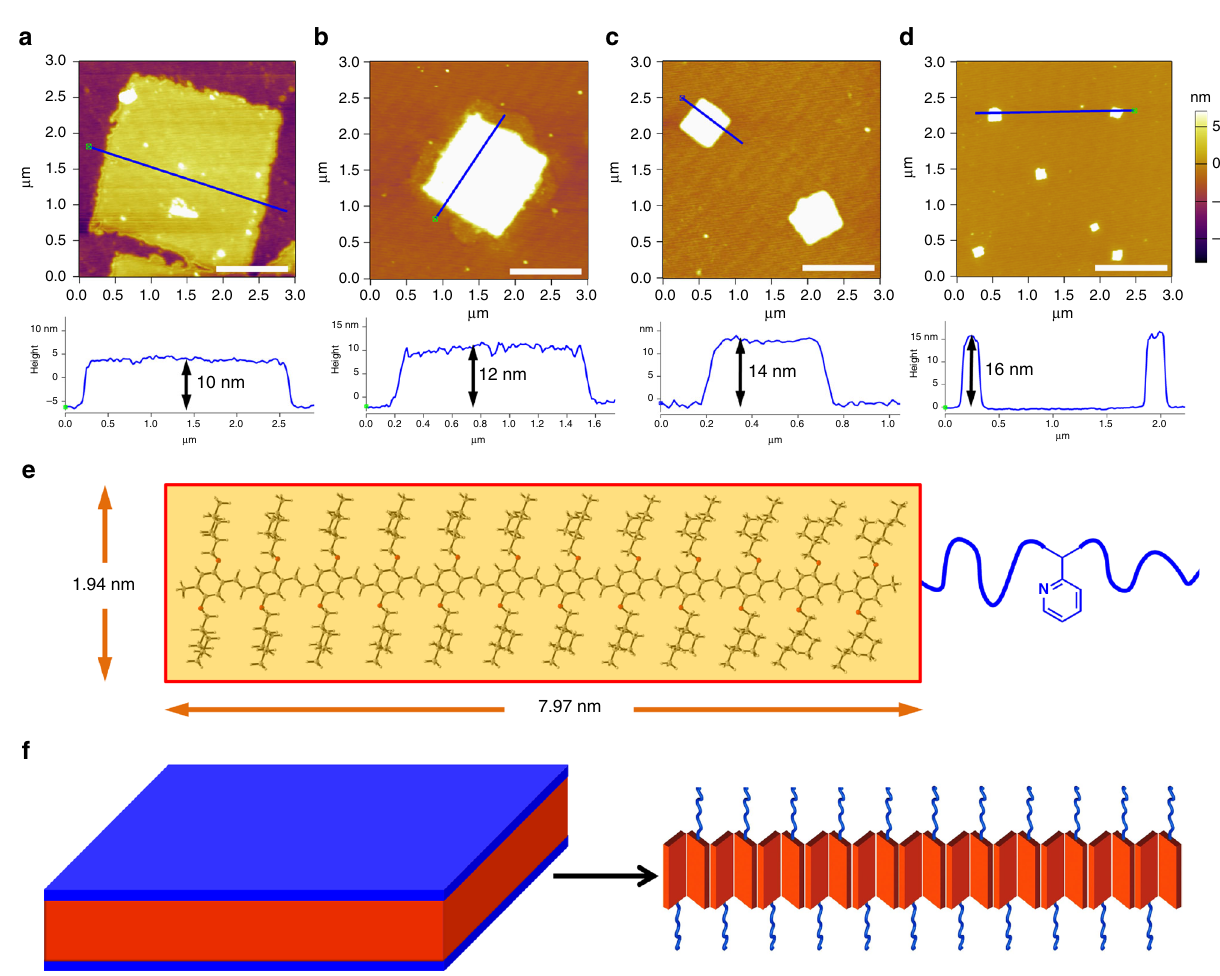
Fig. 2 Probable conformation of platelet 2-D square micelles. AFM images of 2-D square micelles obtained from a 0.01mg ml − 1 2-PrOH solution of PPV 12 - b - P2VP 12 , b 0.01mg ml − 1 2-PrOH solution of PPV 12 - b -P2VP 16 , c 0.05 mgml − 1 2-PrOH solution of PPV 12 - b -P2VP 22 , d 0.05mgml − 1 2-PrOH solution of PPV 12 - b -P2VP μ m in AFM images. e The optimized structure and calculated scales of conjugated PPV 36 in the height mode. Scale bars correspond to 1 12 block by DFT calculations. The DFT calculation was performed with the Gaussian09 suite of programs. The structure was optimized at the B3LYP level of theory with the 6-31G* basis set. f Schematic representation and probable molecular packing of the 2-D square micelles formed by assembly of PPV 12 - b -P2VP